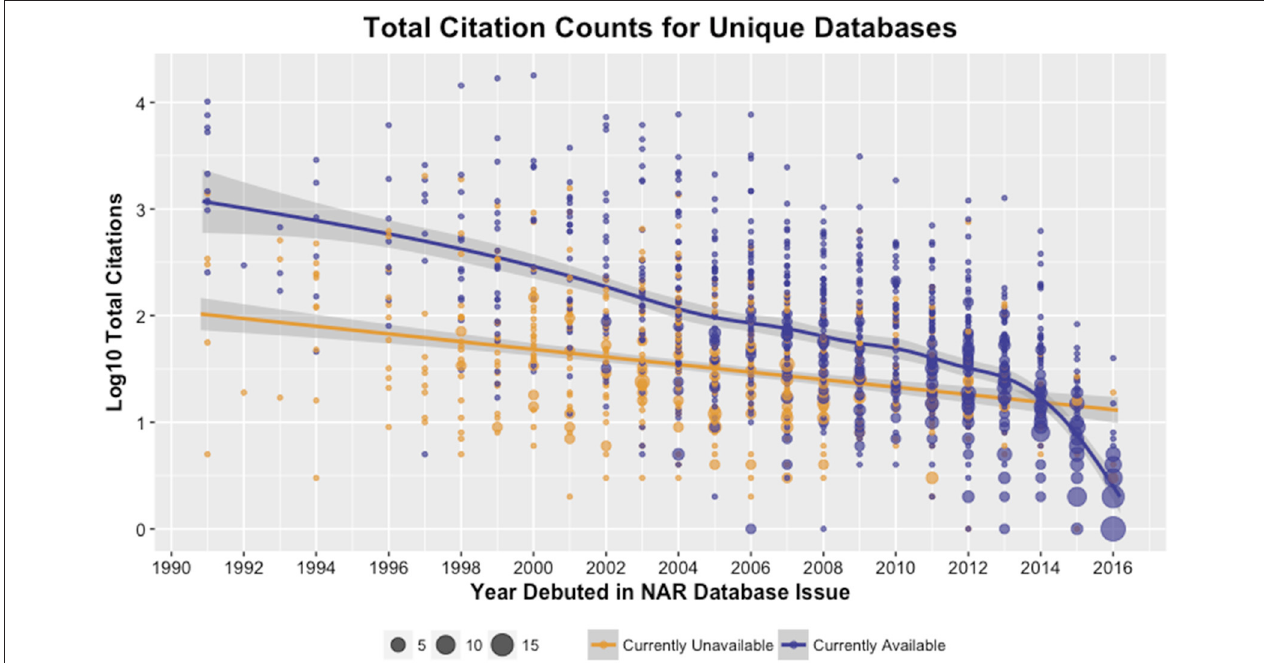
FIGURE 3 | Total citations (displayed as log10) across all articles that describe a given database are higher for databases that remain available (purple) than for those no longer available (orange). In this analysis of raw citation counts, the time dependence of citations is stronger for currently available databases than those that tested as currently unavailable. Points are scaled to represent the number of databases for a given citation count and debut year. To better fit local means, especially for more recent years, a generalized additive model function was used, and curves are shaded with 95% confidence intervals.